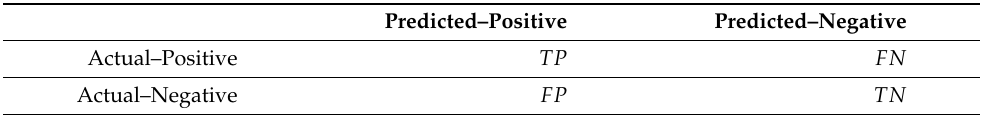
Table 1. The representation of the confusion matrix for binary classification task. True Positive (TP): the label and the prediction are positive, False Positive (FP): the label is negative, but the prediction is positive, False Negative (FN): the label is positive, but the prediction is negative, and True Negative (TN): the label and the prediction are